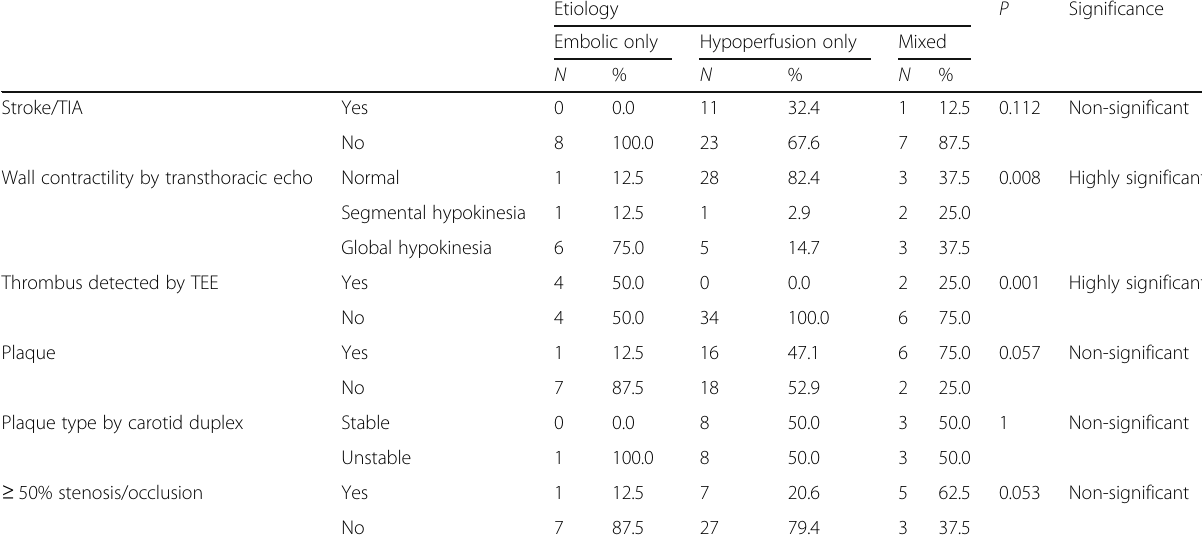
Table 3 Association between embolic, hypoperfusion, and mixed watershed infarction (by MRI perfusion and transcranial Doppler) and patients ’ risk factors (chi-square test